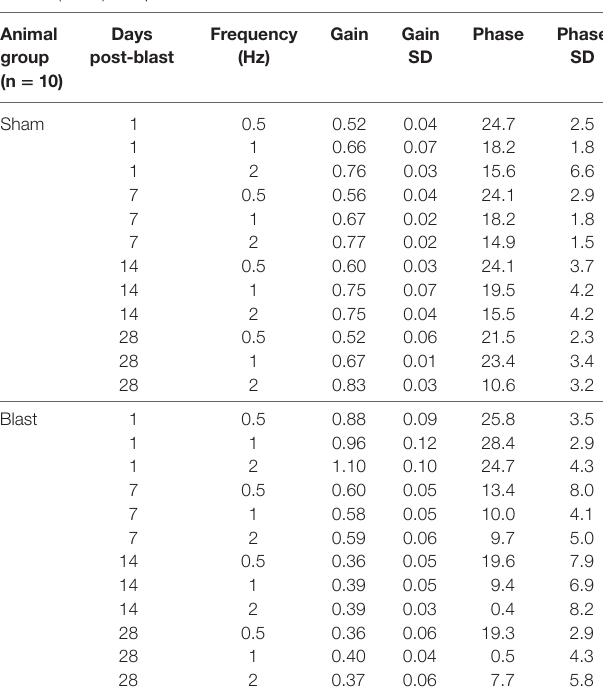
TaBle 1 | Mean horizontal vestibuloocular reflex gain and phase values for control (sham) and post-blast animals.